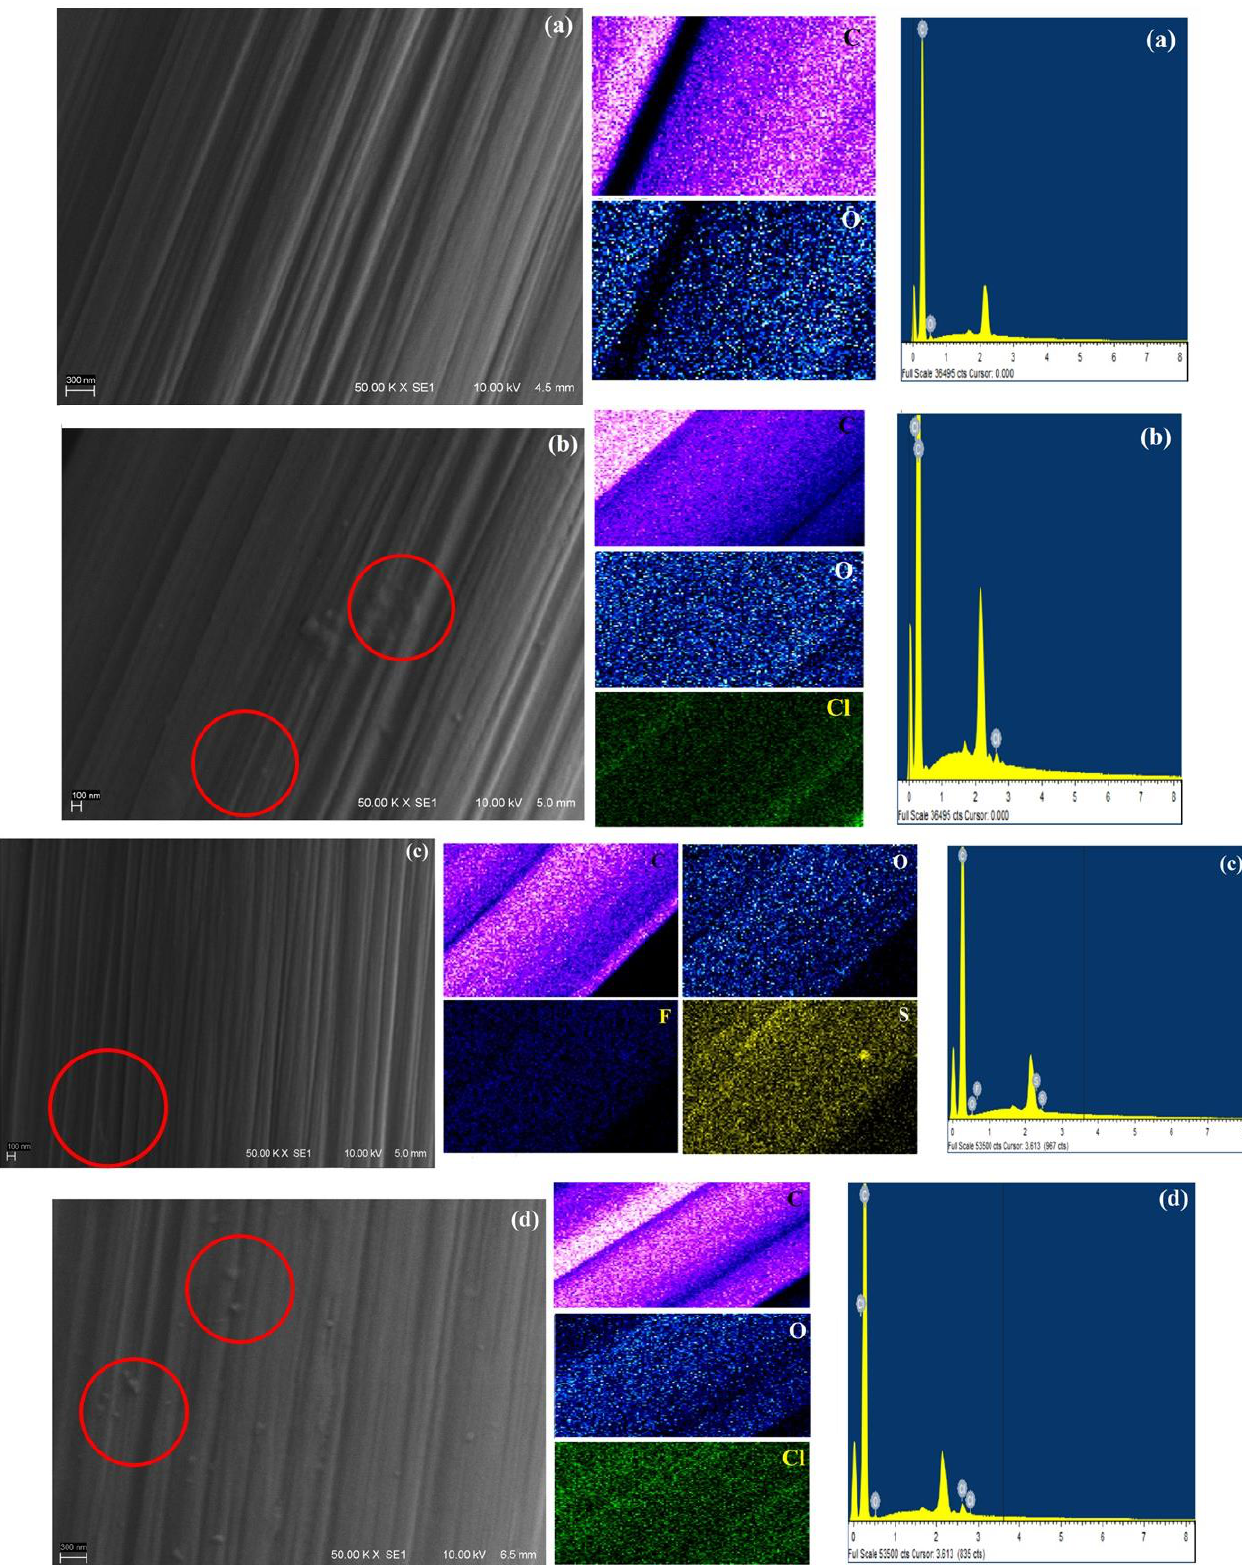
Figure 6 . SEM micrographs, elemental maps and EDS spectrum of the samples: ( a ) CF, ( b ) CF-1Cl, ( c ) CF-1NTf 2 and ( d ) CF-1OH.